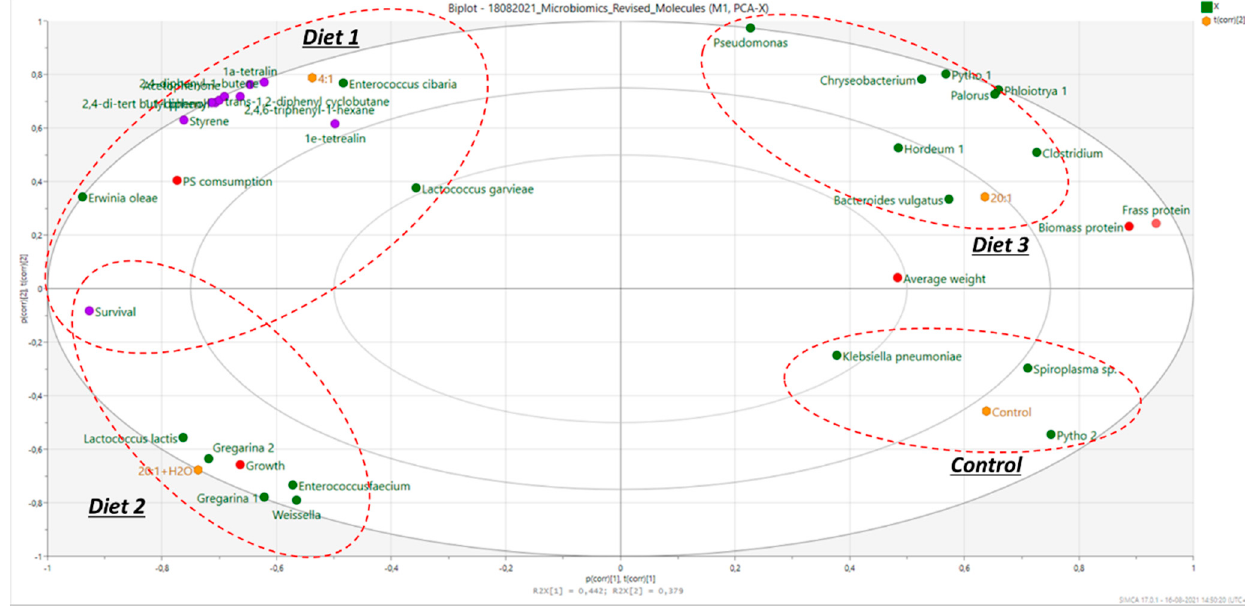
Figure 2. PCA biplot for the analysis of the applied diets in relation to the associated microbiome (purple dots: monomers/oligomers/plastic-oriented compounds; red dots: physical condition and protein/nitrogen of insects; green dots: microbial species). Was.